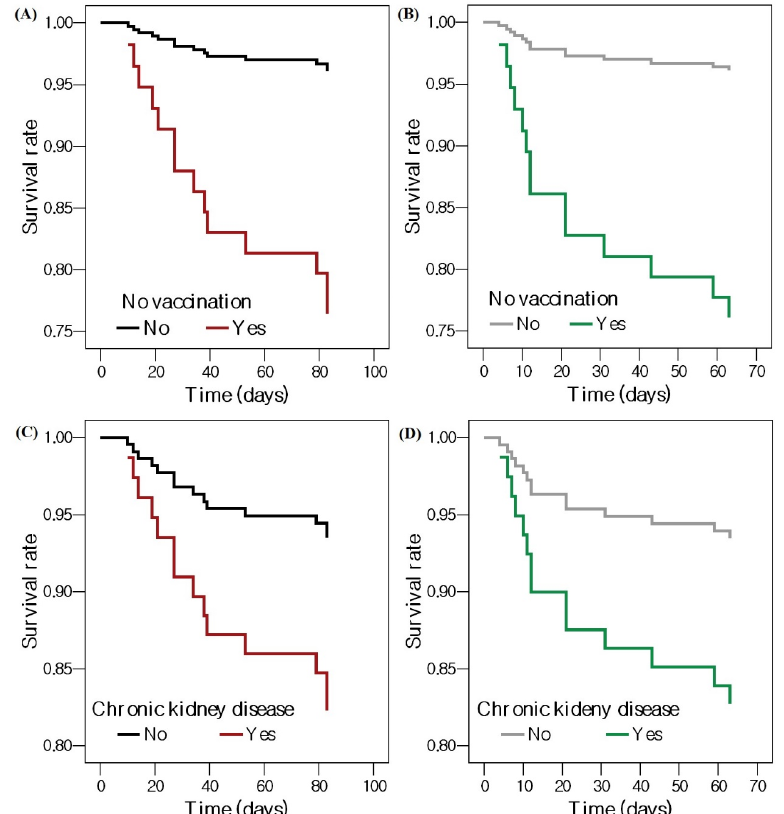
Figure 2. Cox proportional survival curves showing the effects of no vaccination on patients with nosocomial COVID-19 ( A ) from the time of admission and ( B ) from the time of diagnosis with nosocomial COVID-19, and chronic kidney disease in patients with nosocomial COVID-19 ( C ) from the time of admission and ( D ) from the time of diagnosis with nosocomial COVID-19. Abbreviation: COVID-19, coronavirus disease 2019.